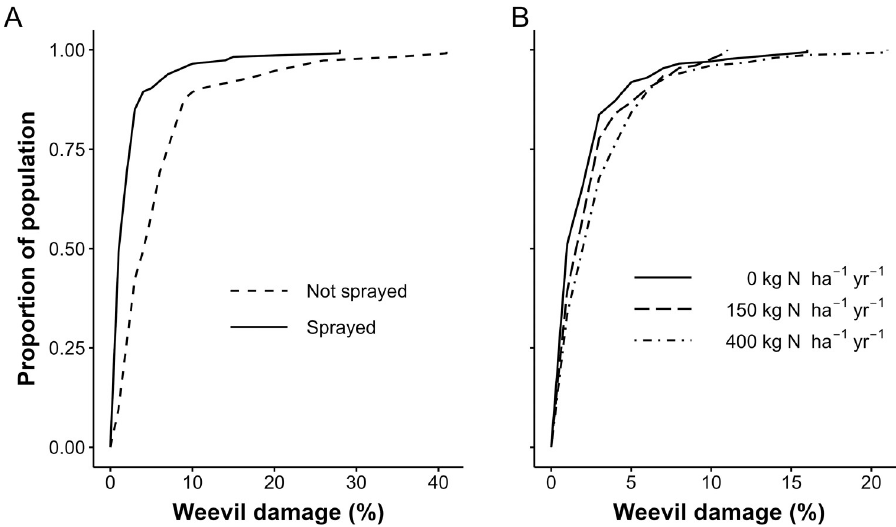
Fig 1. The cumulative distribution function for weevil damage in EAHBs with and without spraying chlorpyrifos (A) and at different N application rates in sprayed treatments (B) in the nutrient omission trial.